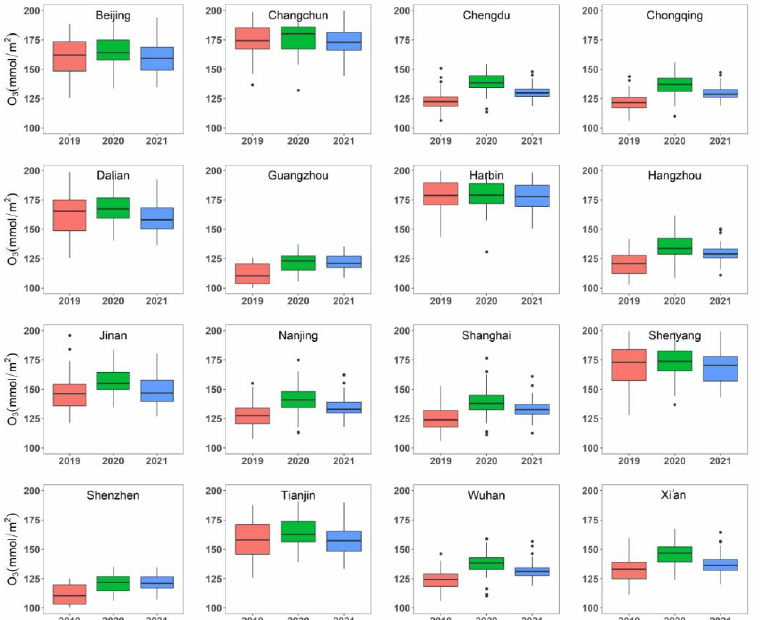
Figure 4. Box plot of the atmospheric O 3 concentration in the study periods for the years 2019, 2020, and 2021. The box represents the inter-quartile range (IQR) and the average value (i.e., the line inside). The two whiskers show (Q3 + 1.5 × IQR) or the maximum value and (Q1 − 1.5 × IQR) or the minimum value, respectively.